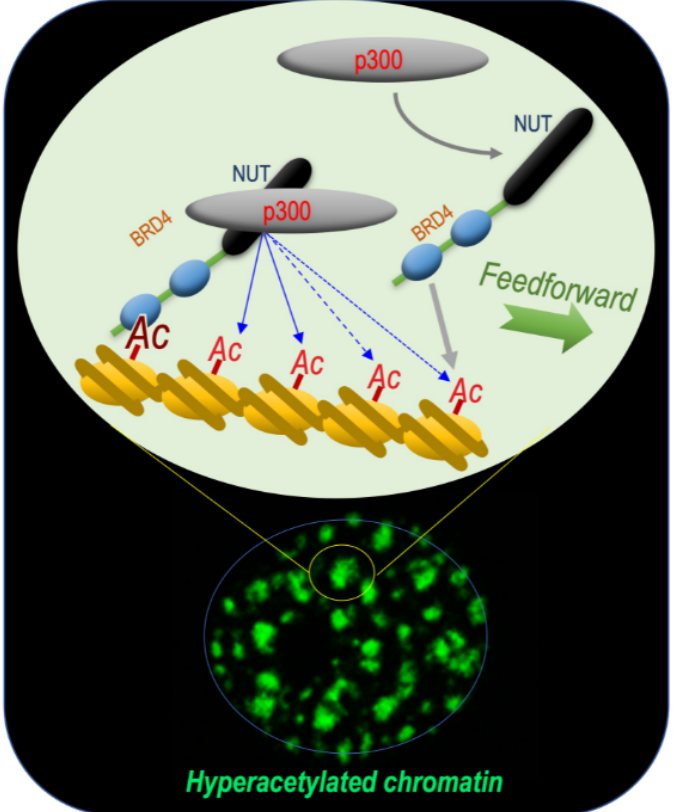
Figure 1. BRD4-NUT and p300 cooperate to induce hyperacetylated chromatin domains through a chromatin acetylation/binding loop feedforward mechanism. The mechanism schematized is based on data published by Reynoird and colleagues [3]. The scheme represents our understanding of the mechanism underlying the initiation and propagation of hyperacetylated chromatin domains leading to the creation of multiple BRD4-NUT/p300-hyperacetylated chromatin foci. The initiation of the process corresponds to the binding of acetylated nucleosomes by BRD4, the recruitment of p300 by NUT and the enhancement of p300 catalytic activity, leading to the acetylation of adjacent nucleosomes. These new sites of histone acetylation recruit additional BRD4-NUT molecules, which in turn recruit p300 and a feedforward loop of histone acetylation-BRD4-NUT binding starts. The BRD4-NUT/p300 dependent histone acetylation propagation encounters opposing deacetylase activities constraining the acetylation propagation. The limits of the acetylated chromatin foci are dy- namic and could move forward or backward depending on the opposing activities of acetylation and deacetylation.